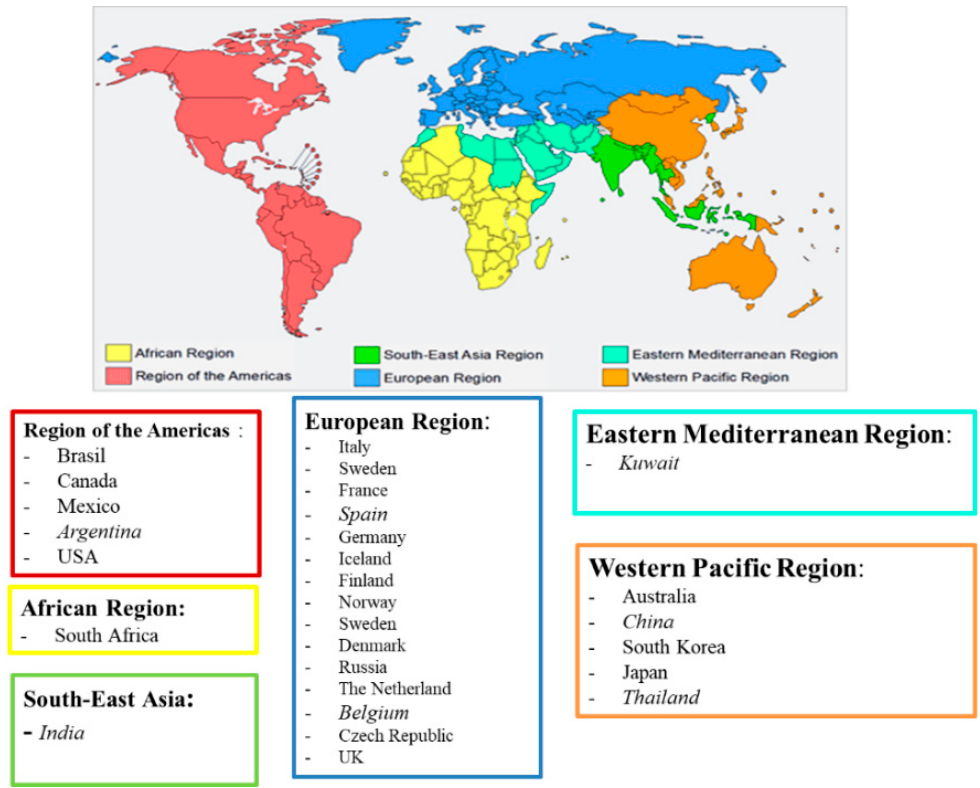
Figure 1. WHO Collaborating Centers that responded to the global survey. Legend: the countries reported in italics are those that did not respond to the survey (Argentina, India, Spain, Belgium, Kuwait, China,